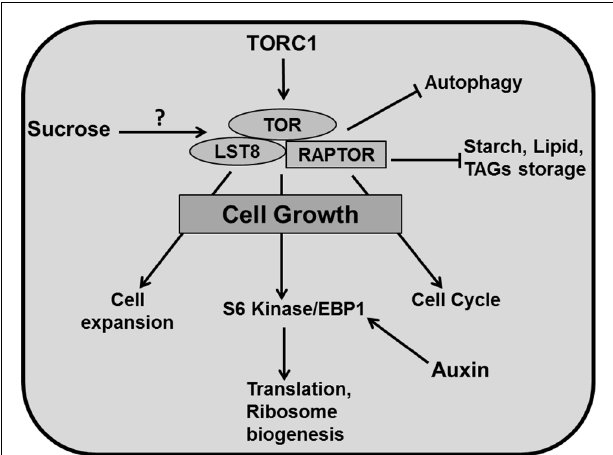
FIGURE 5 | Cytoplasmic growth. TOR is the central regulator of diverse growth processes.TOR, RAPTOR, and LST8 are major components of TORC1 in plants.TOR has been reported to regulate different metabolic processes and positively controls cell expansion, cell cycle, translation, ribosome biogenesis (through phosphorylation of S6 kinase/EBP1).TOR activity inhibits autophagy and accumulation of carbon resources such as starch and lipids like triacylglycerides (TAGs). Auxin positively regulates EBP1 proteins. It has been reported that sucrose positively affectsTOR activity (pointed andT shaped arrows indicate positive and negative regulation and question mark indicates an unknown mechanism,